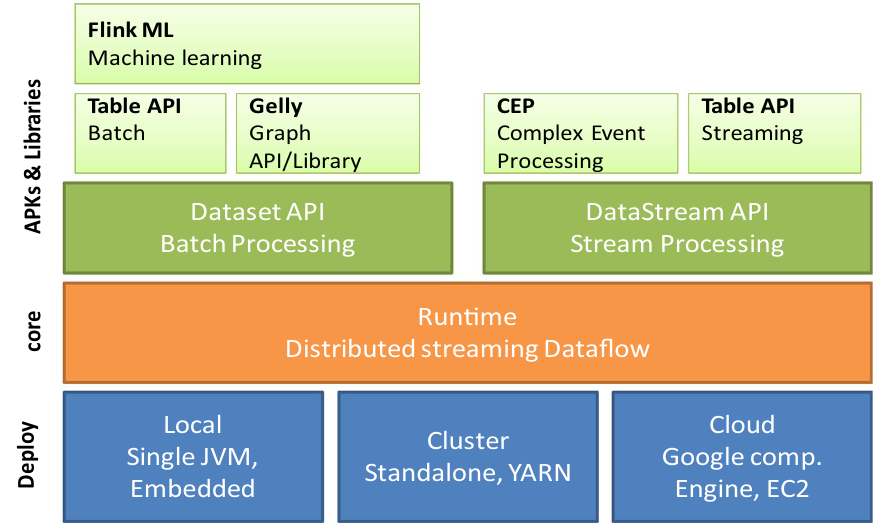
Fig. 8 The Apache Flink Ecosystem